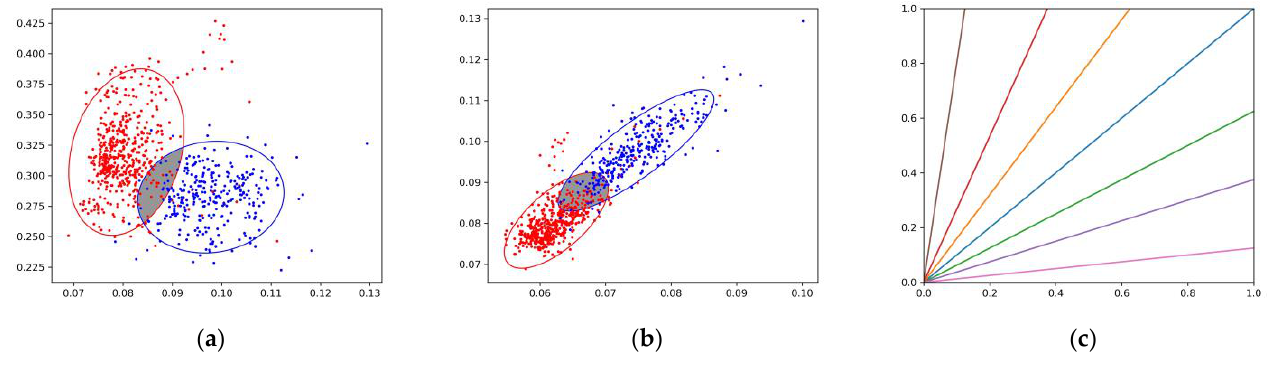
Figure 6. Schematic chart of a standard deviation ellipse. The red and blue dots and circles in ( a ) and ( b ) represent the two types of sample points and the standard deviation ellipse they form, and the gray part indicates the overlapping area. ( a ) is the normal intersection of 2 standard deviation ellipses, ( b ) appears a particular case where the centers of the two standard deviation ellipses and the origin almost course a straight line, and ( c ) are some straight lines through the origin, where the indices constructed by the normalized interpolation method have the same value on the same line.